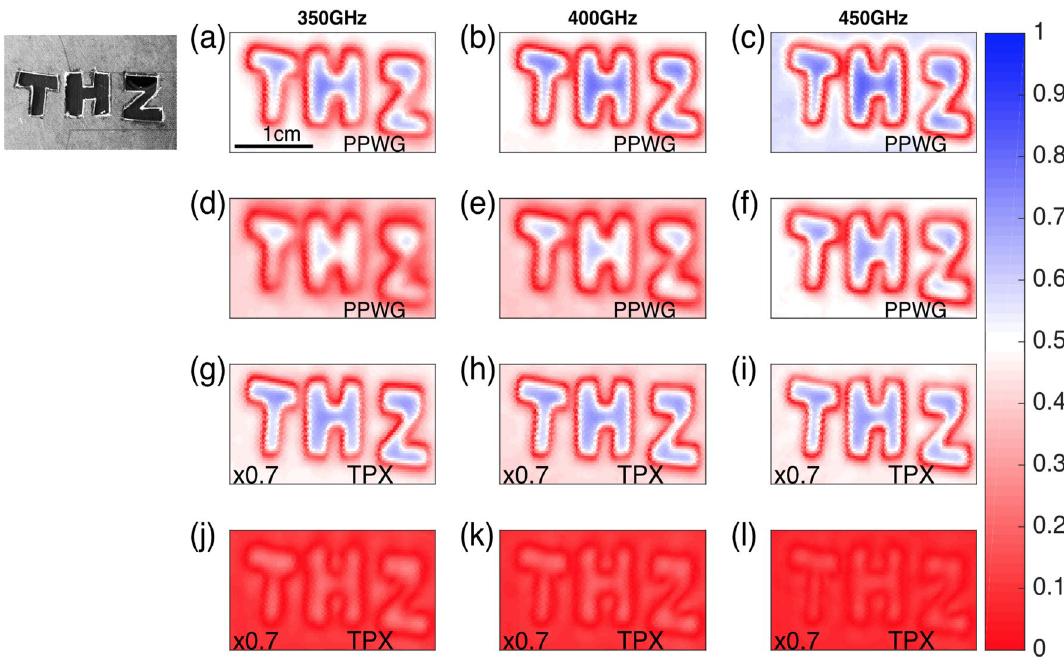
Figure 5. Image reconstruction at the focal point of the PPWG axicon at ( a ) 350 GHz, ( b ) 400 GHz and ( c ) 450 GHz. ( d – f ) Image reconstruction 3 cm after the focal point of the PPWG axicon at the same frequencies. In ( g – i ) the reconstruction was obtained using the TPX lens and placing the sample at its focal position. Finally, in ( j – l ) the sample was translated 1 cm beyond the focal point of the TPX lens. Inset, photograph of the